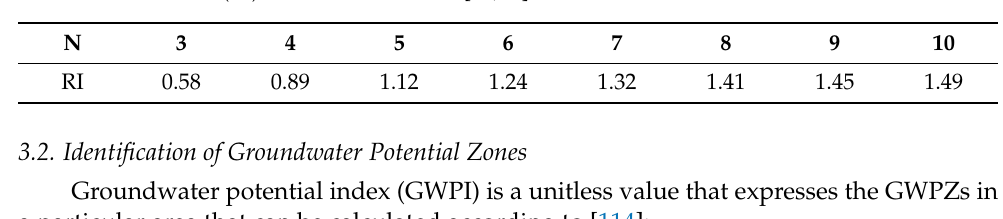
Table 6. Ratio index (RI) for various n scores [82,83].